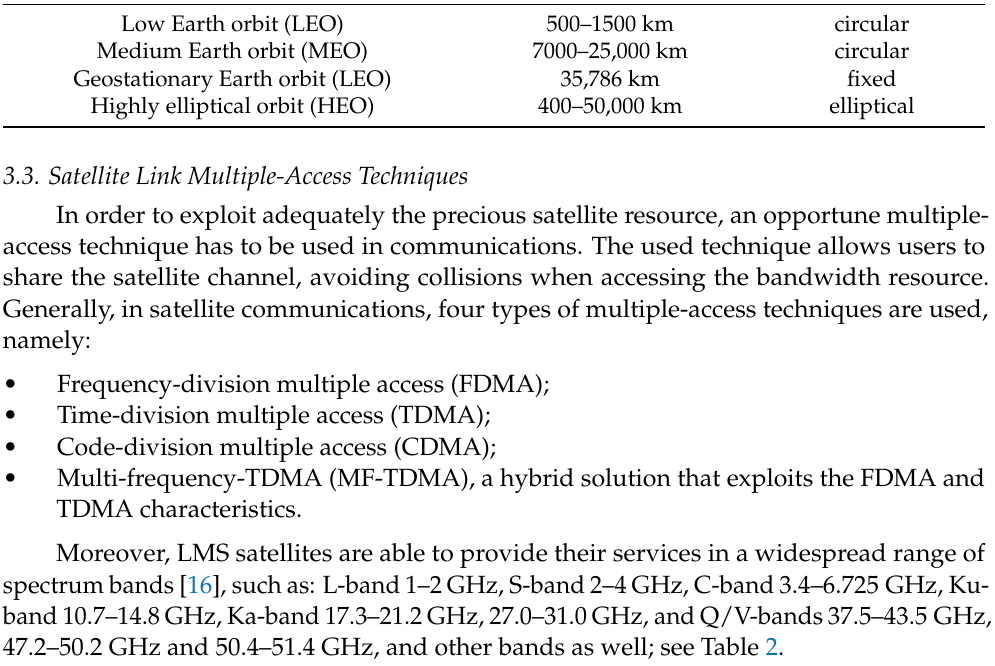
Table 1. Satellite Orbit Classification. Platform Altitude Orbit Low Earth orbit (LEO) circular Medium Earth orbit